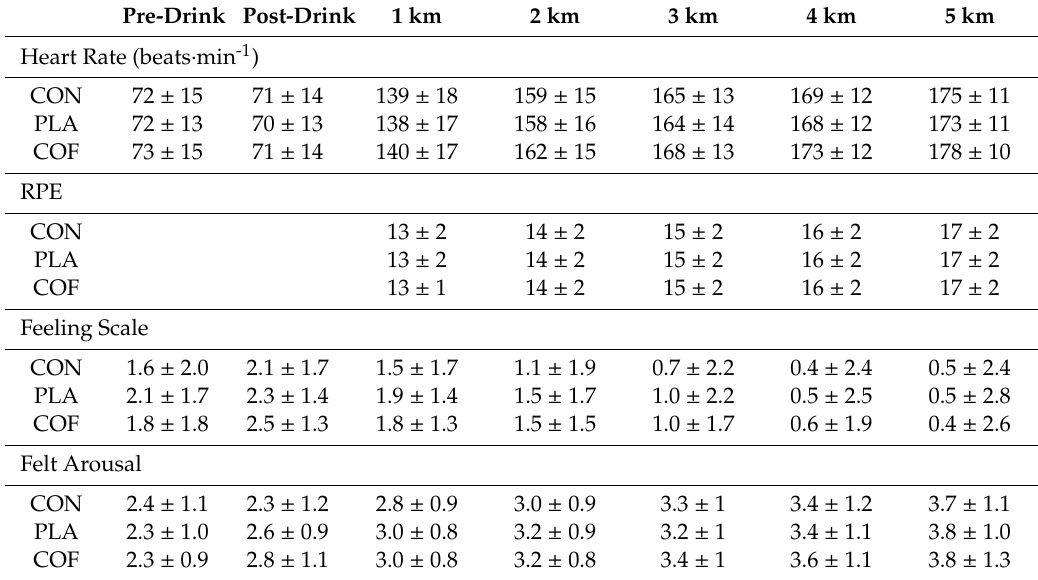
Table 2. Mean ± SD heart rate, rating of perceived exertion (RPE), feeling scale and felt arousal during the 5 km cycling time trial ( n =